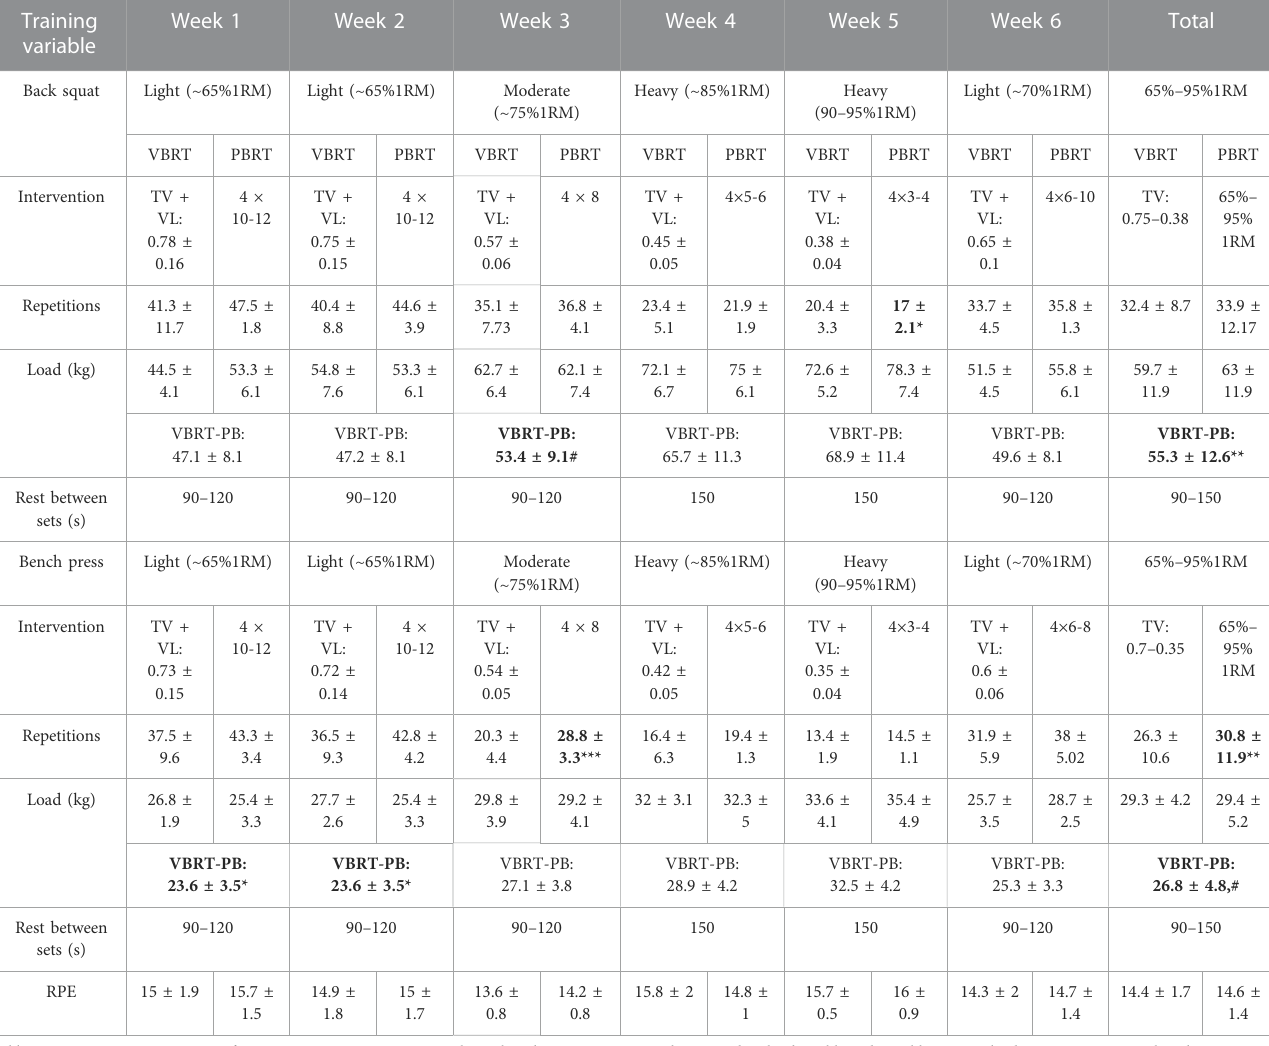
TABLE 2 Descriptive characteristics of the resistance training program performed by both experimental groups over the 6-week training period. Training variable